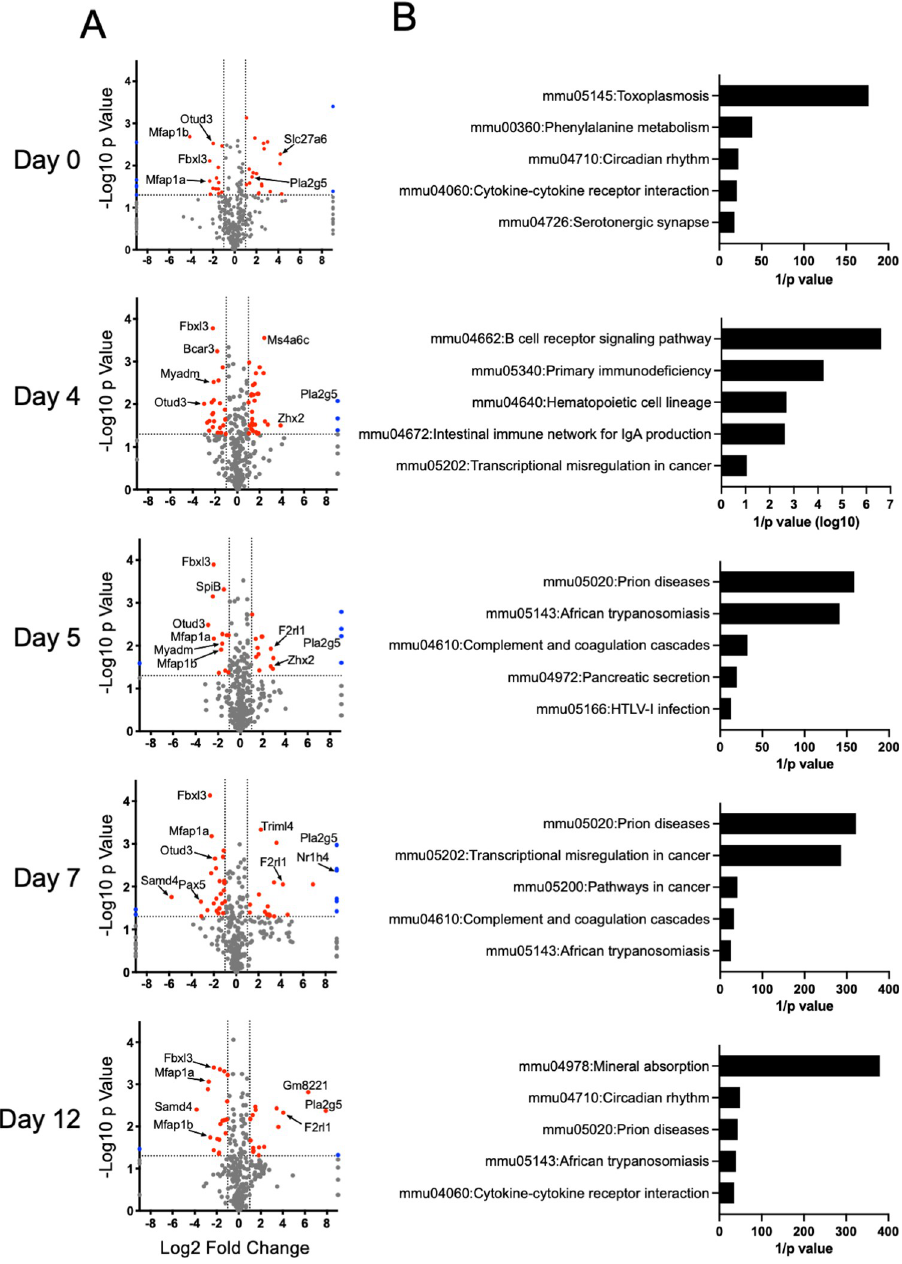
Fig 4. The ADRB2 selectively regulates transcriptional pathways involved in diverse immune functions. ( A ) Differentially expressed genes between WT and Adrb2 -/- cells at each time point of infection are displayed in volcano plots, and select genes contributing to major KEGG pathways are denoted within the plots. ( B ) KEGG pathway analysis was performed with the differentially expressed genes at each time point. The top five pathways are displayed. All pathways were found to be significantly enriched at p �